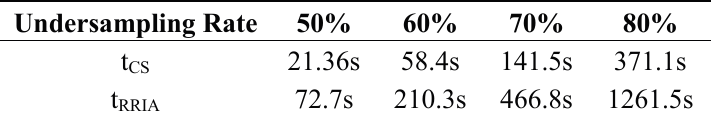
Table 3. The computation time of the basic CS approach and RRIA.